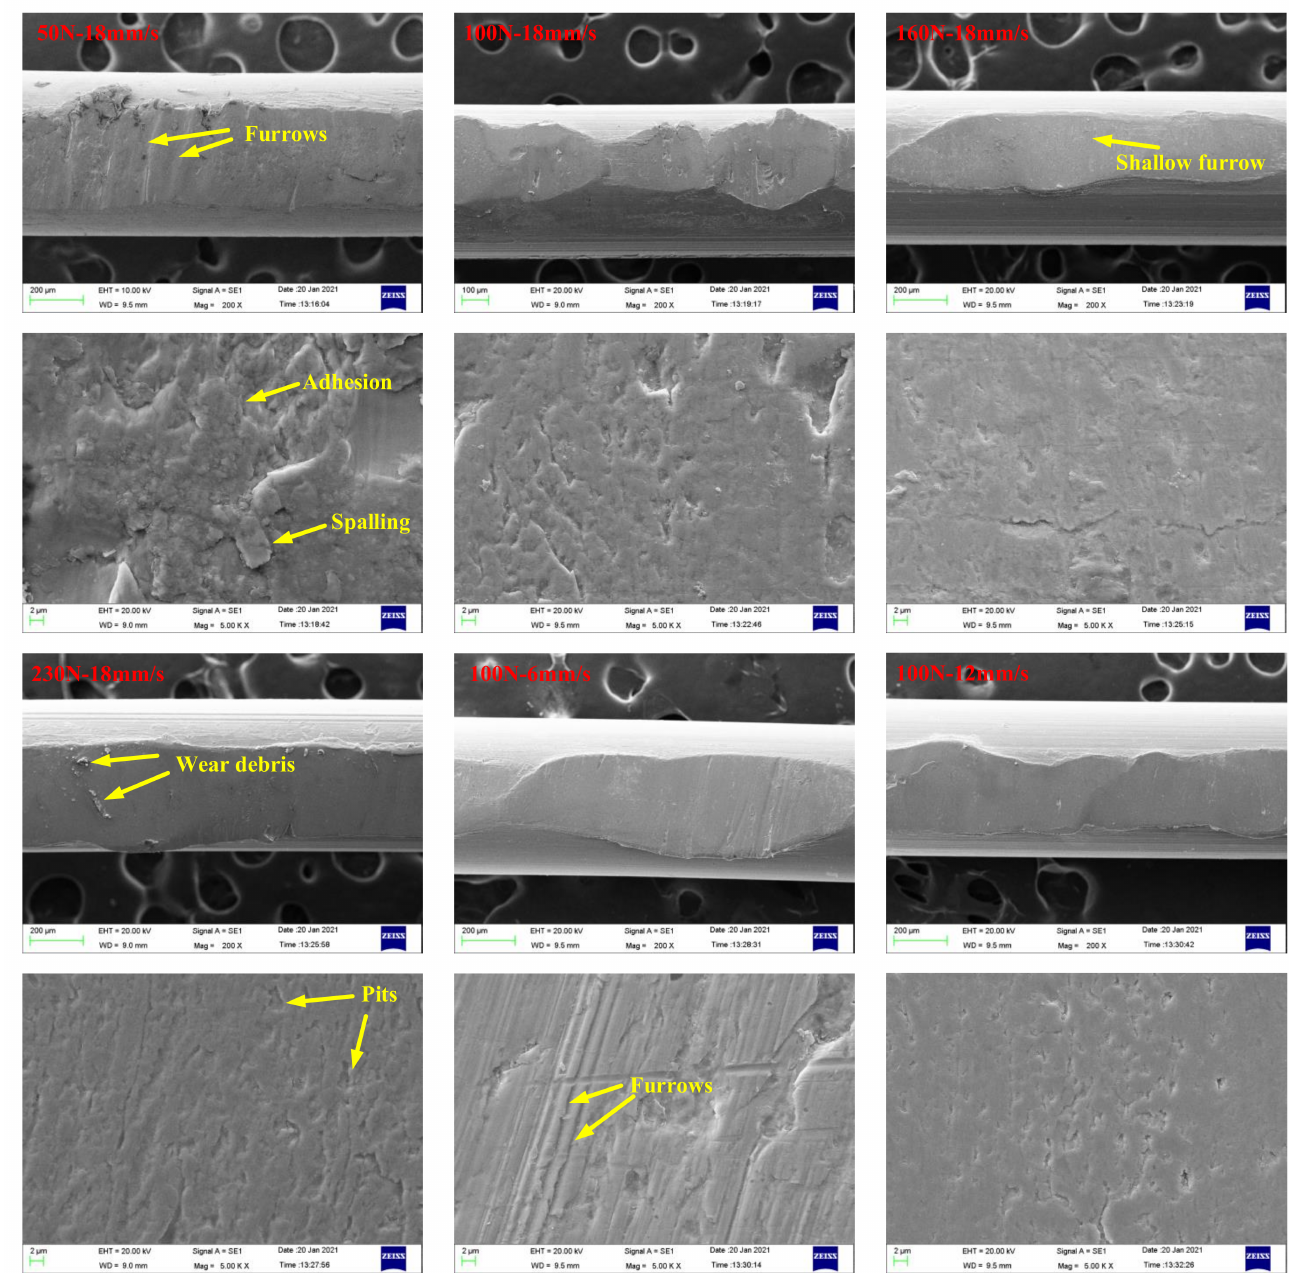
Figure 16. SEM images of wear scars of wire ropes lubricated with